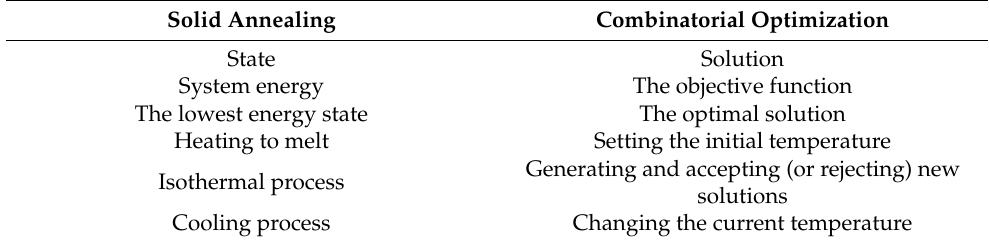
Table 5. Solid annealing vs. combinatorial